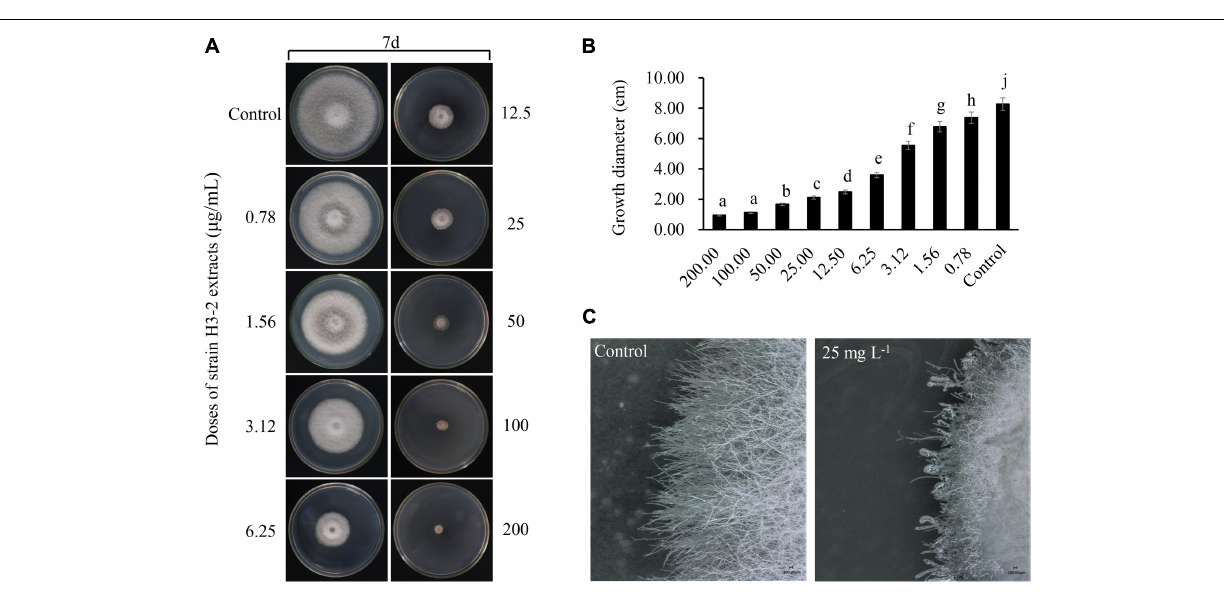
FIGURE 3 | Effects of strain H3-2 extracts on mycelial growth of Foc TR4. (A) Mycelial growth of Foc TR4 on PDA medium treated with different concentrations of H3-2 extracts. (B) Quantitative analysis of Foc TR4 growth diameters. Different lowercase letters represent a significant difference according to the Duncan’s multiple range test ( p < 0.05). (C) Colonial edge profiles observed using a light microscope. Bar = 100 µ